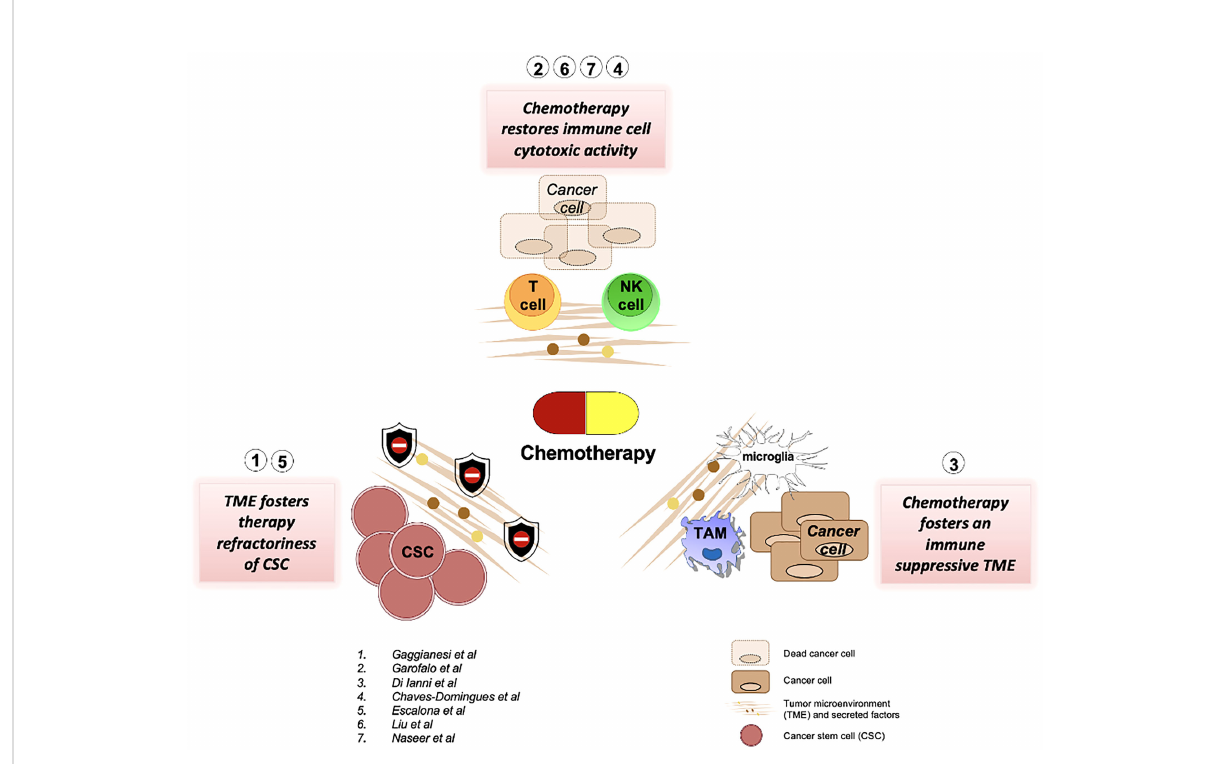
FIGURE 1 A collective summary of the articles published in this research